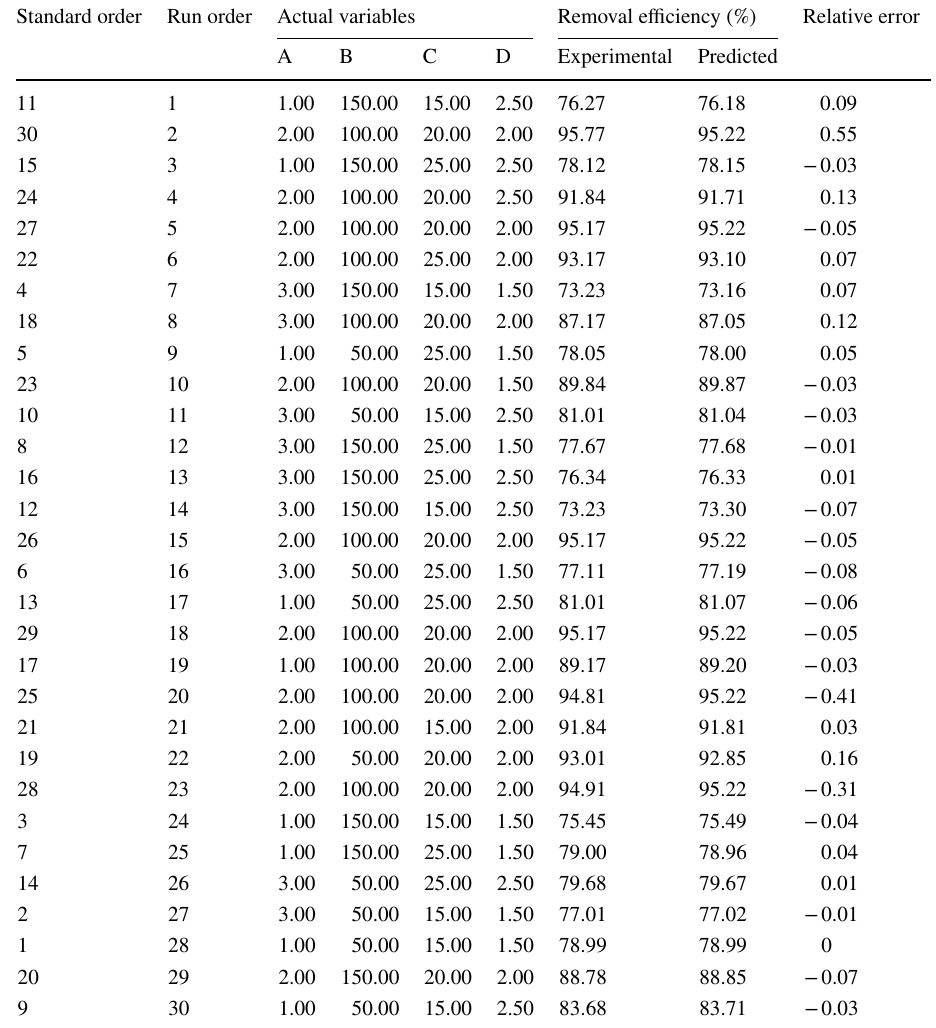
Table 5 Experimental design matrix generated by CCD for removal of Cr(VI) on Teff husk activated carbon